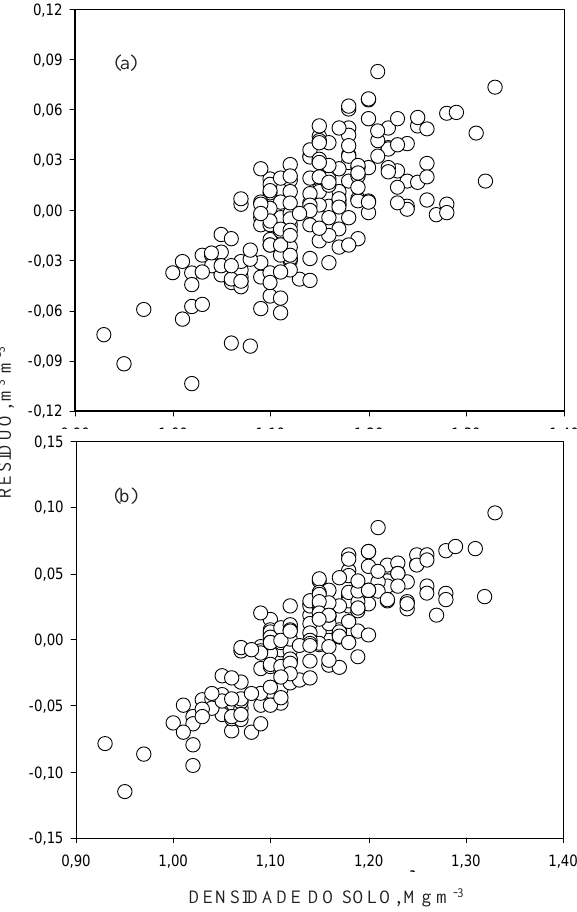
Figura 1. Distribuição dos erros da umidade ( qqqqq medido - qqqqq estimado) em relação à densidade do solo para os modelos de VG (a) e HC